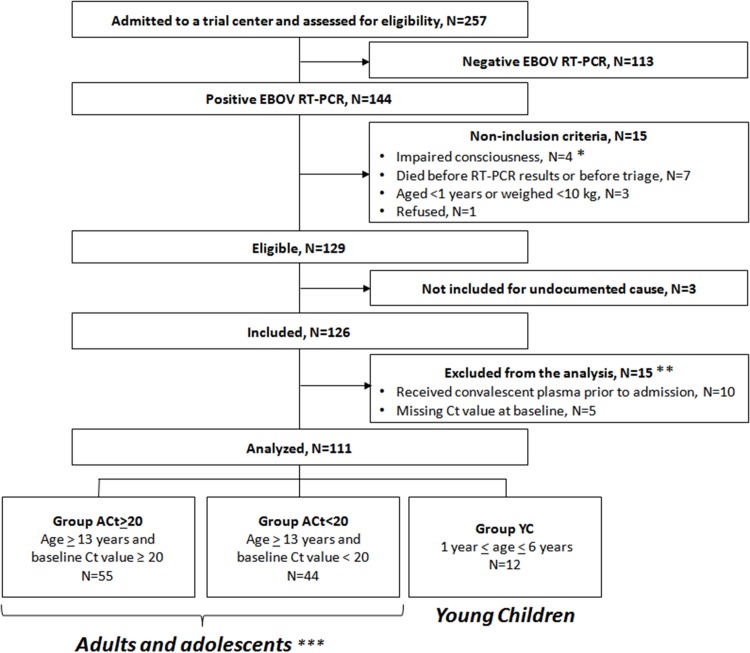
JIKI trial flow chart.*Including a pregnant woman. **Of the 15 patients excluded from the analysis, four died (received plasma: n = 3/10; missing Ct value, n = 1/5) and 11 survived. ***All aged ≥13 y because no child aged 7–12 y attended the trial centers during the study period.